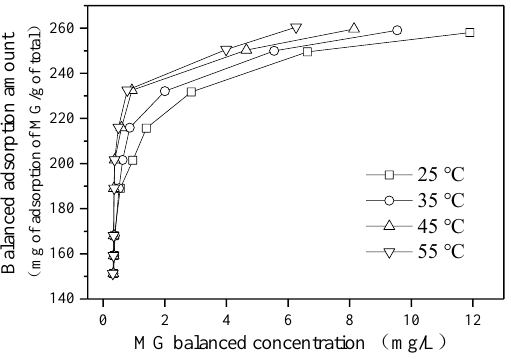
Figure 6. Adsorption isotherm of malachite green. To ensure the adsorbed saturation, the samples were oscillated for at least 10 h at a certain temperature in a constant temperature oscillating box. Table 1. Langmuir linear fitting results of organic sepiolite adsorption of malachite green. Temperature (°C) Regression Equation